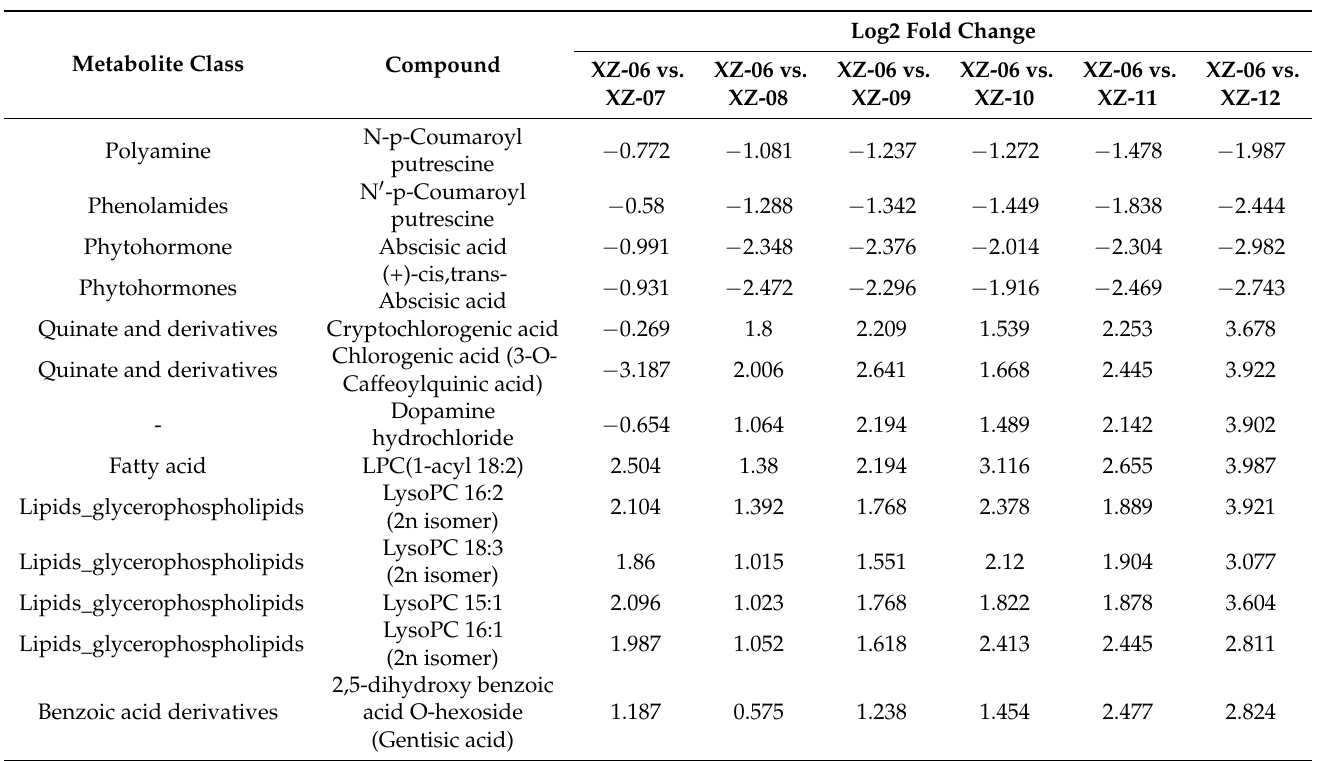
Table 4. Consistently and differentially accumulated metabolites between wolfberry fruits from six salt-alkaline stress